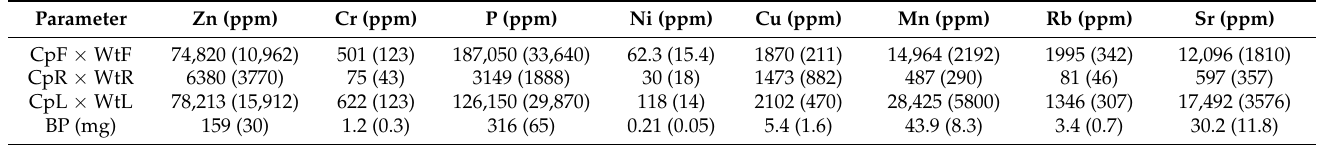
Table 4. Estimation of bioextracting potential (BP) for each chemical element when using the MAP system in the VDM containing 2 m 3 of substrate (50:50, v / v consisted of contaminated soil: volcanic